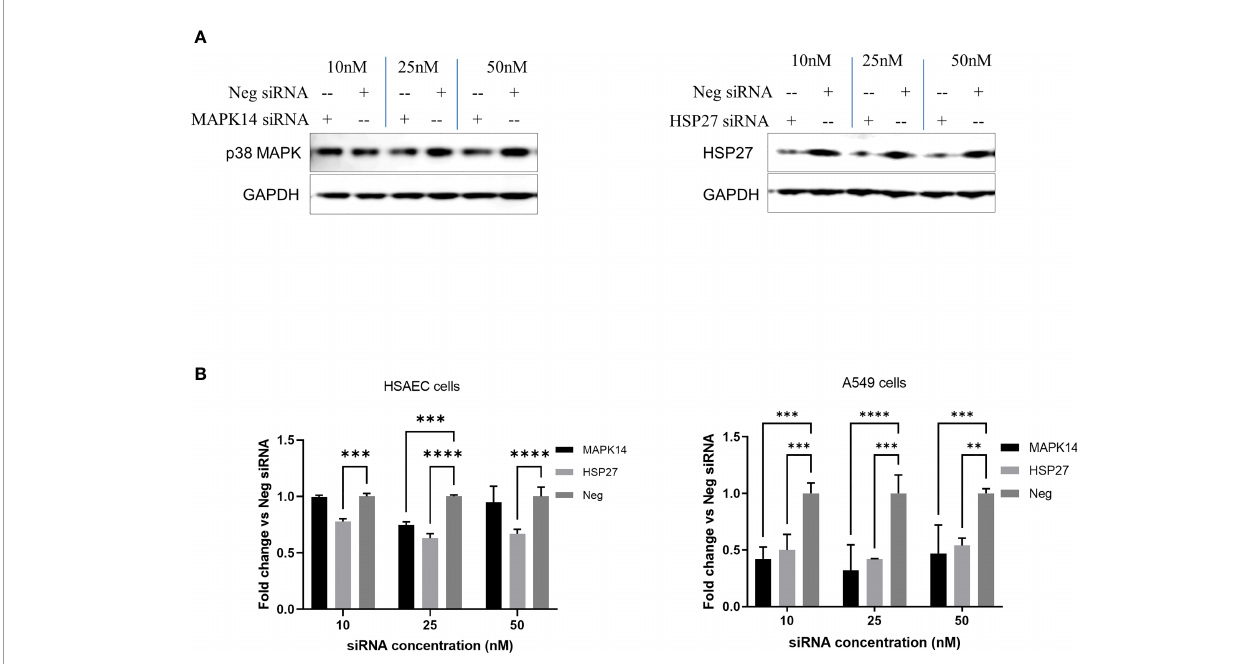
FIGURE 4 | siRNA knockdown of p38 MAPK and HSP27 decrease JUNV infection. HSAEC and A549 cells in a 96-well plate were transfected with 10 – 50 nM of siRNA with DharmaFECT 1 transfection reagent in triplicate, HSAEC cells were transfected in duplicate plates. (A) Forty-eight hours post transfection HSAEC cells in one 96-well plate were lysed for Western blot analysis, 3 wells per condition were combined per lane to assess the level of protein knockdown. (B) Another 96-well plate per cell line was infected with JUNV CD1 with an MOI of 1, 24-hours post infection the JUNV nucleocapsid was stained with a mouse monoclonal anti-N antibody and detected with an Alexa fl uor-488 conjugated secondary. The signal was measured by high content imaging, data shown were triplicate biological samples in a single experiment, and these are representative of three experiments for HSAEC cells and one experiment for A549 cells. **p=0.0019, ***p<0.001,